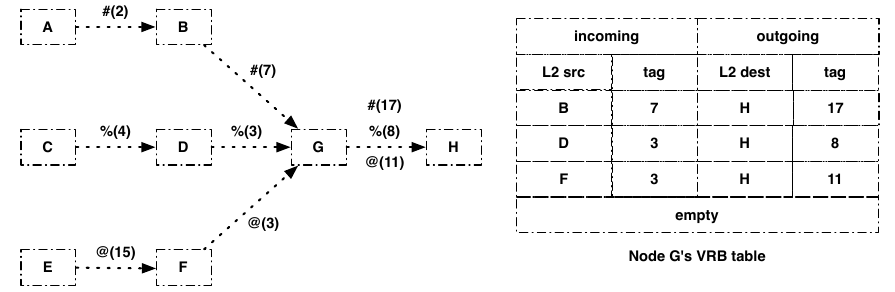
Figure 4. VRB table of node G: #(2), %(4) and @(15) are fragments of the packets denoted #, %, and @ coming from nodes A, C and E, respectively, with datagram tag configured to 2, 4 and 15,